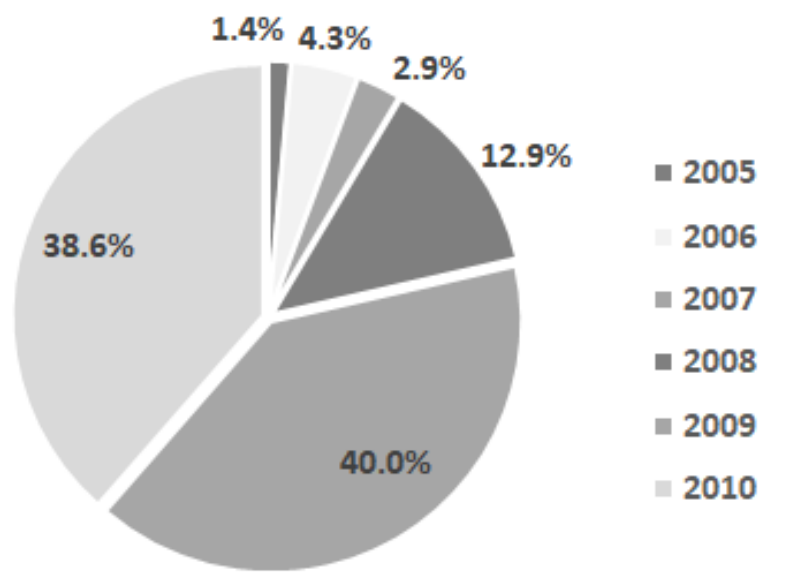
Figure 1. Distribution of our sample according to the year of their birth. The distribution of children by place in the sequence of sibling births indicates that two-thirds of the children included in the study were the first-born, and about one-third of the children were the second-born, with one child being the third-born (Figure 2).